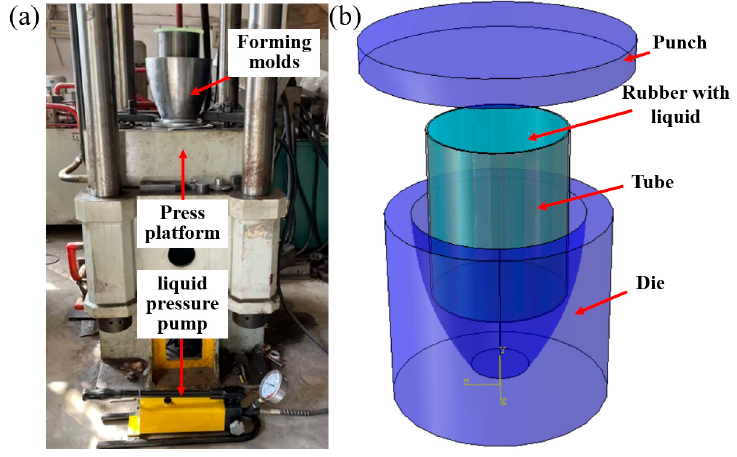
Figure 16. The equipment and simulation model for TUBG. ( a ) The equipment for TUBG, ( b ) The simulation model for TUBG.